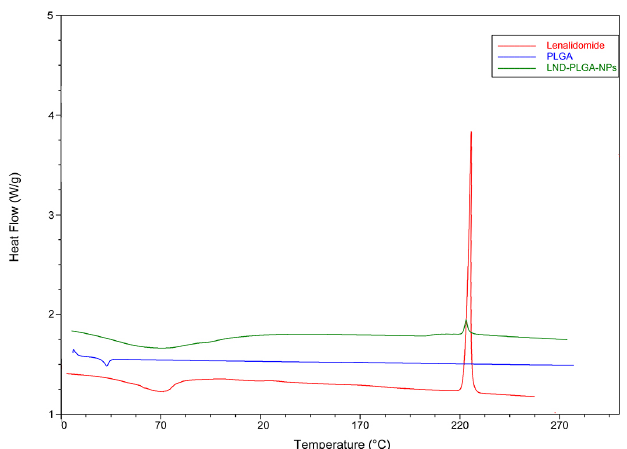
FIGURE 5 - DSC curves of lenalidomide, PLGA, and lenalidomide -PLGA-NPs.